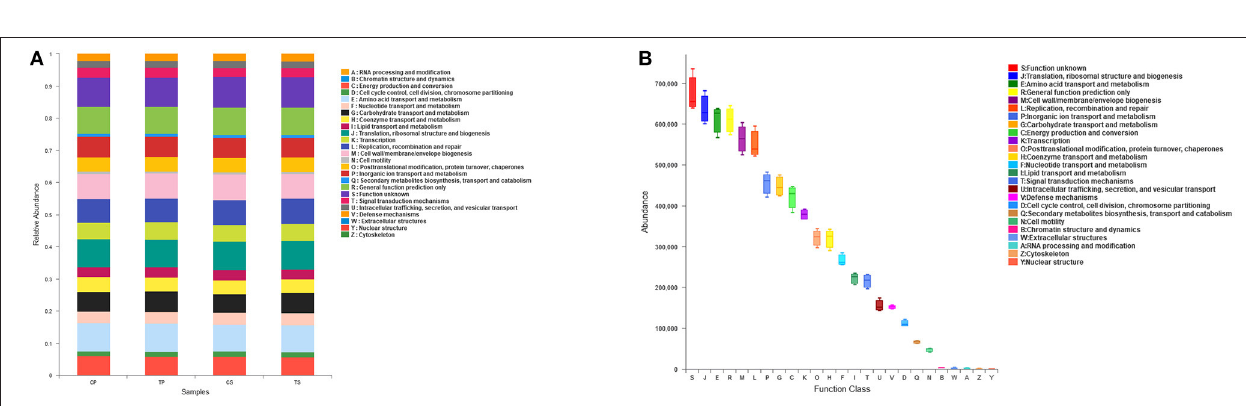
FIGURE 8 | Function prediction by PICRUSt. (A) The compositions of COG function in the four groups. (B) The abundance of COG function in all